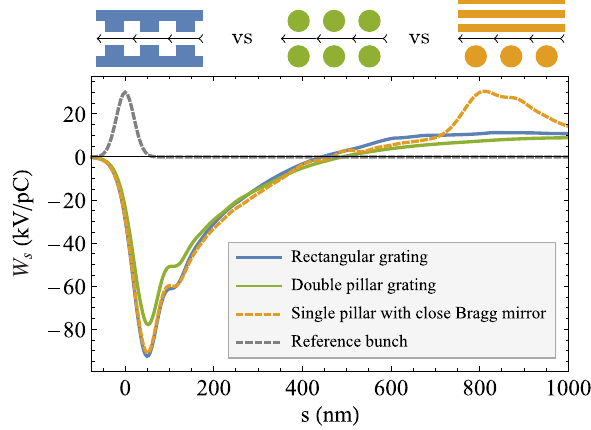
FIG. 5. Longitudinal wake per grating period of a Gaussian bunch distribution passing on-axis through a dual-layer rectan- gular grating structure (blue), a dual pillar structure (green) and a single-row pillar structure, where the second row is replaced by a Bragg mirror (yellow). The reference bunch distribution is shown in dashed